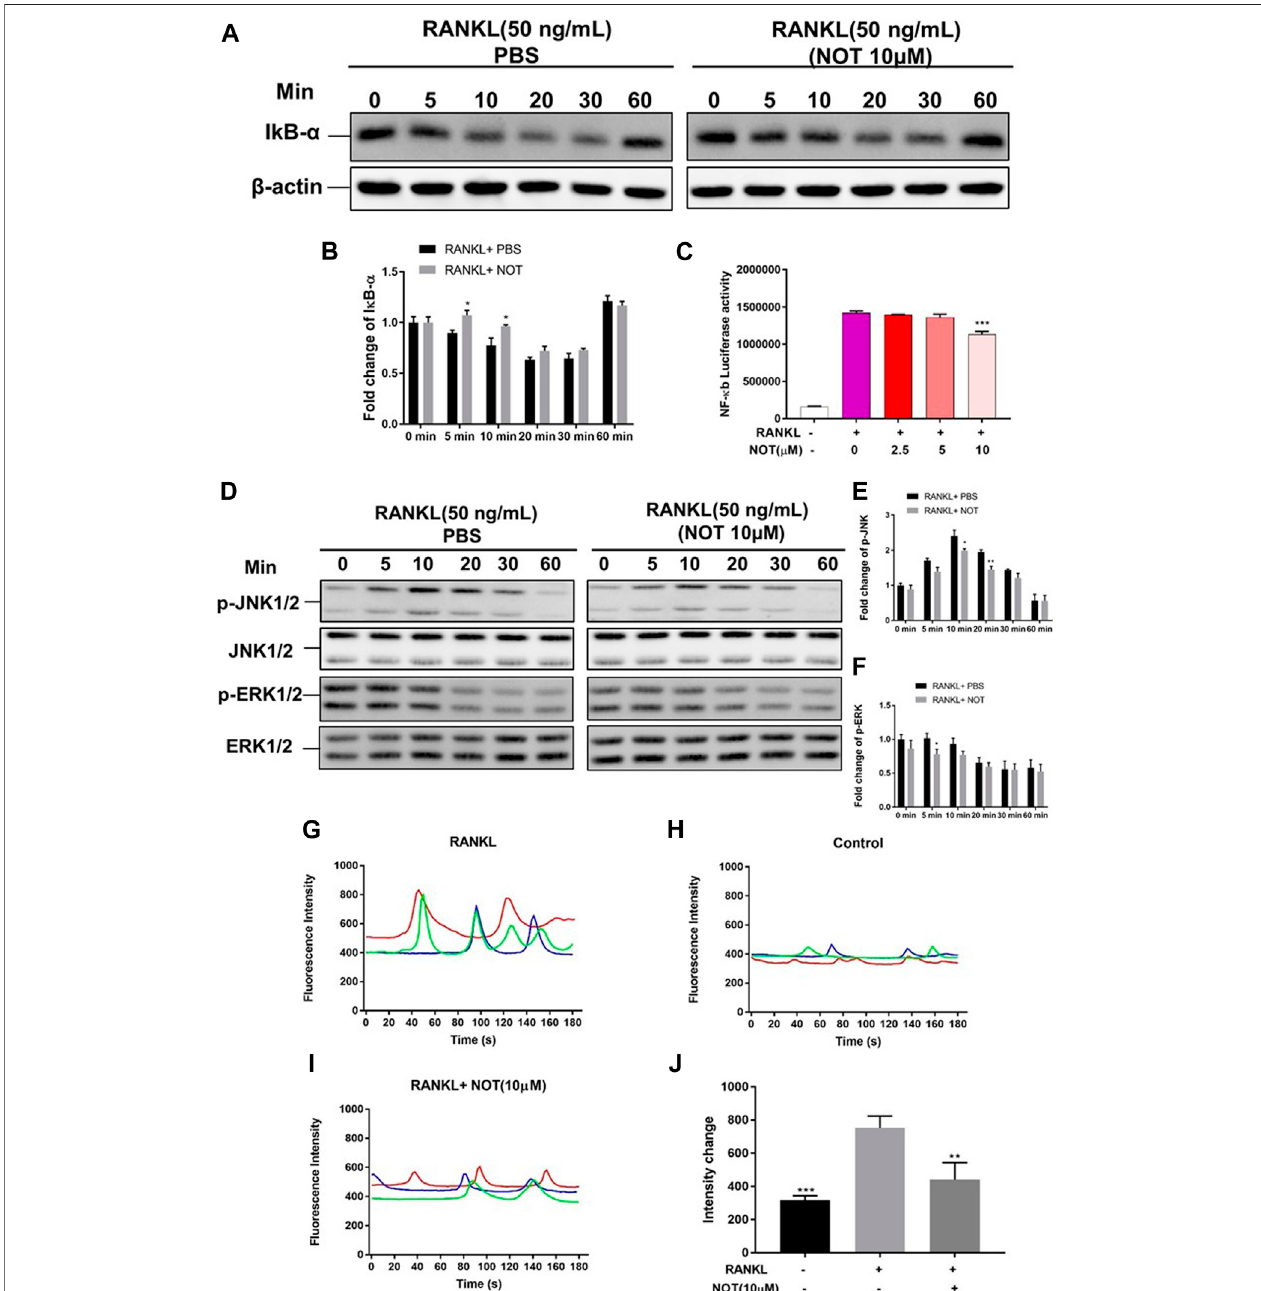
FIGURE 4 | Notopterol represses NF- κ B, MAPK activation and calcium oscillation during osteoclastogenesis. (A,B) Representative Western blotting images (A) and quanti fi cation analysis (B) of I κ B- α from BMMs which were induced with M-CSF and RANKL in the presence of NOT (10 μ M). (C) Luciferase activity in RANKL stimulated RAW264.7 cells transfected with an NF- κ B luciferase construct. NF- κ B luciferase activation was decreased following exposure to various concentration of Notopterol. (D) Representative images of western blots suggesting the expression level of p-JNK1/2 and p-ERK1/2 normalized to JNK1/2 and ERK1/2. (E,F) Quantitative analysis of the fold change in p-JNK1/2 and p-ERK1/2 expression after Notopterol treatment. (G – J) Representative images of Ca 2+ oscillation pattern stimulated by RANKL (G) , negative control (M-CSF only) (H) , 10 μ M Notopterol treatment prior to RANKL stimulation (I) . (J) Quanti fi cation of intensity of Ca 2+ oscillation capturedacrossmultiplecellsforeachconditionandmaximumpeakintensityminusbaselineintensity( n (cid:2) 3).Dataarepresentedasmean ± SEM.All invitro experiments were repeated three times with similar results. Signi fi cant differences between the control and treatment groups are shown as * p < 0.05, ** p < 0.01 and *** p < 0.001.